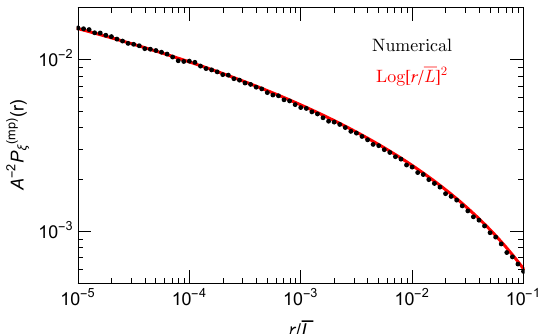
Figure 6 . Normalized 2-point function P (mp) ( r ) as a function of r/L . We fix ‘/L = 10 − 14 and ζ ∆ χ /χ c = 0 . 2 . The black dots are numerical results obtained from eq. (5.16). Red line is the best fit assuming P (mp) ( r ) = c 2 log( r/L ) 2 . ζ